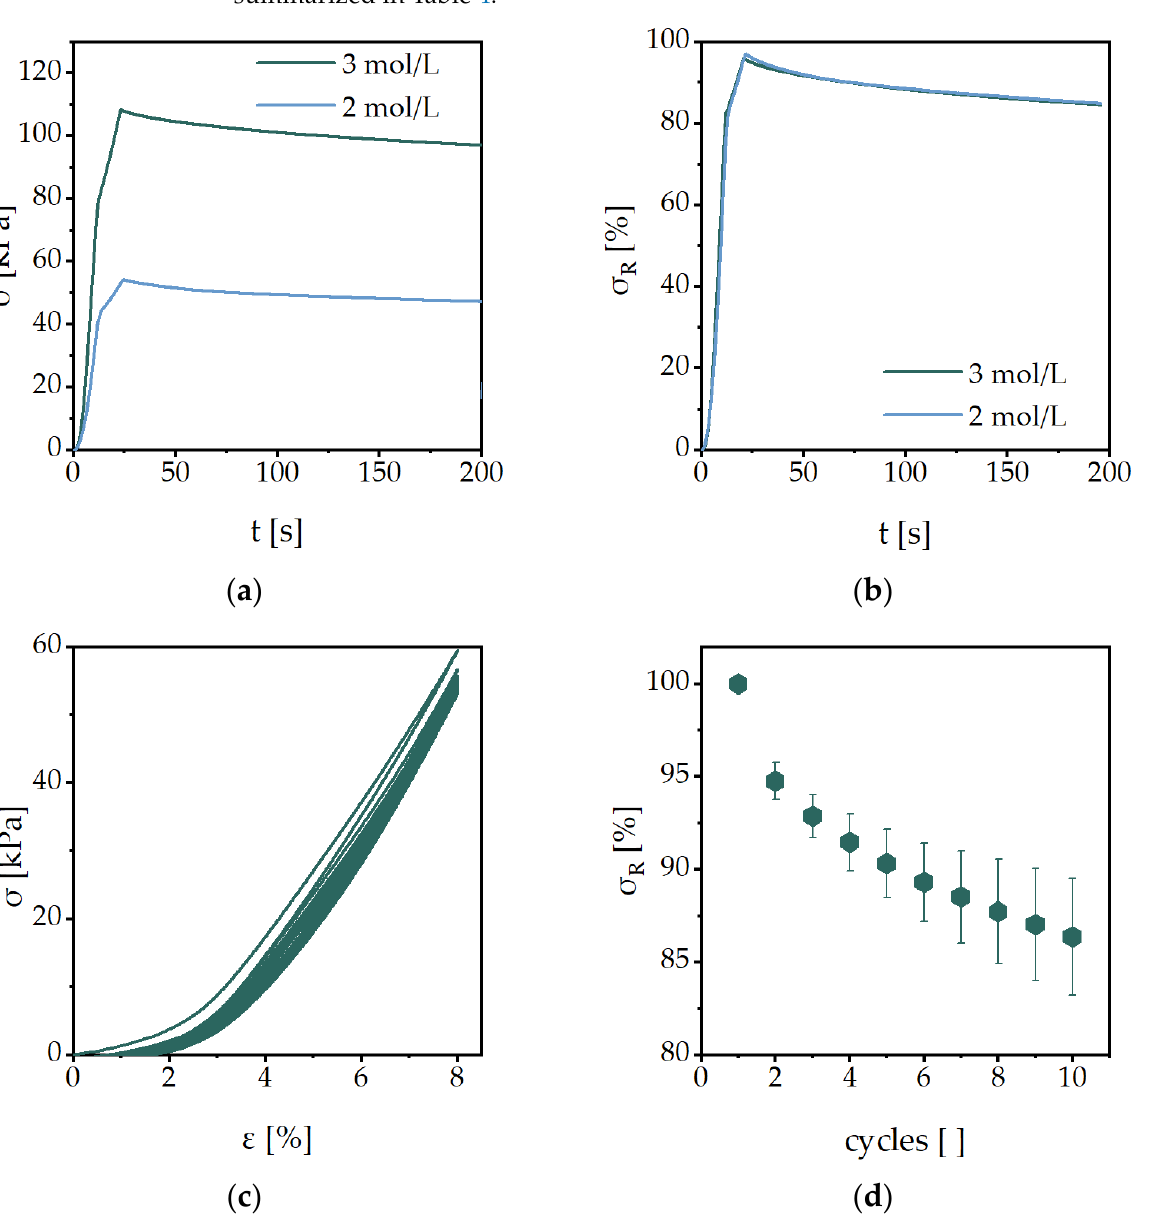
Figure 4. Averaged stress-relaxation profiles of the hydrogels with the monomer AAMPSO 3 (2 mol/L) with BAP (2 mol%) as a crosslinker ( ε = 8%; n = 3) ( a ) to the total stress and ( b ) the residual stress, as well as ( c ) the cyclic compression loading of one AAMPSO 3 sample and ( d ) the normalized residual stress of the averaged AAMPSO 3 samples. Table 4. Residual stress of the investigated hydrogels after different cycles of the cyclic compres- sion loading experiments.